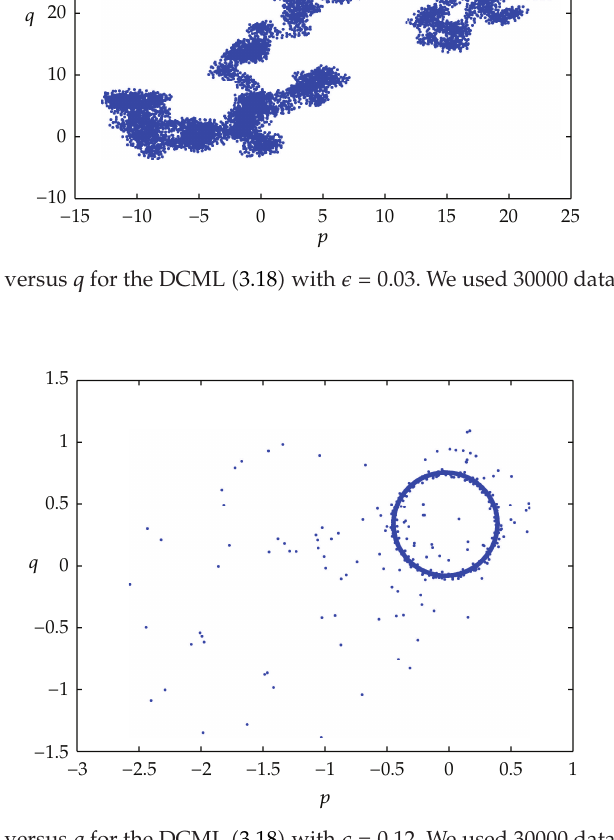
Figure 4: Plot of p versus q for the DCML (cid:3) 3.18 (cid:4) with (cid:2) (cid:8) 0 . 12. We used 30000 data points of x (cid:3) 111 (cid:4)